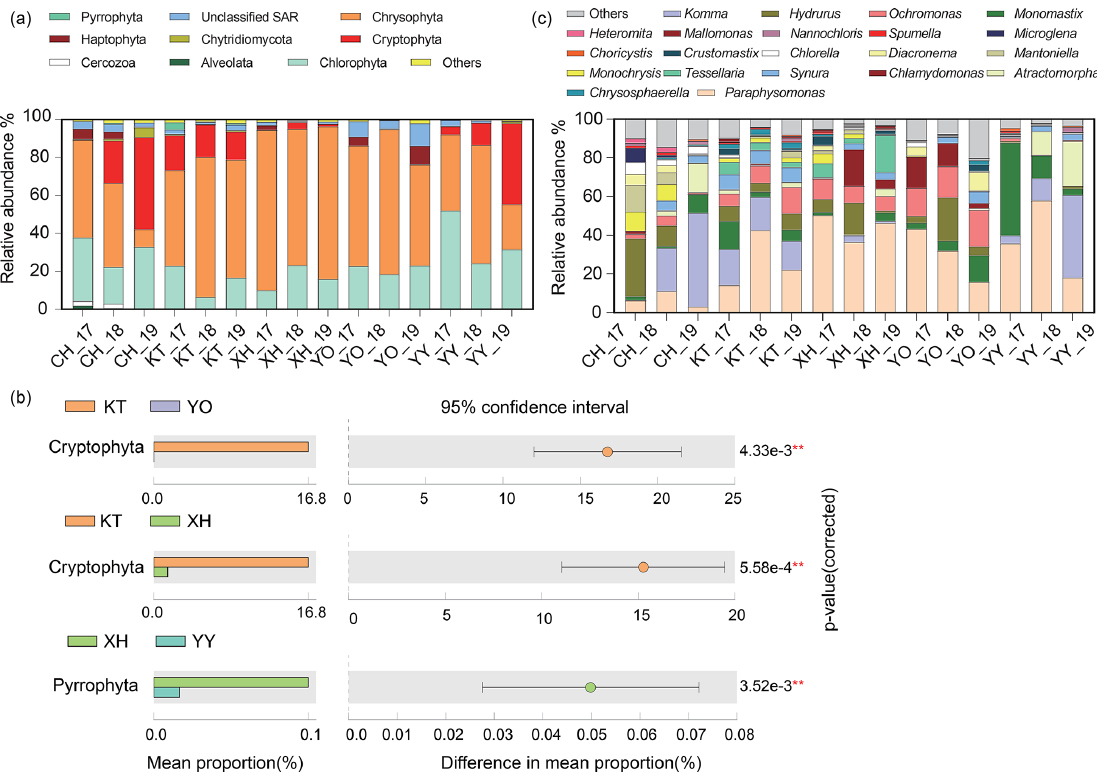
Figure 2. Comparison of microbial eukaryotic community composition. (a) Temporal and spatial dynamics of relative abundance on Phy- lum level in five lakes from 2017 to 2019. The 17, 18, and 19 represent the expedition seasons 2017/2018, 2018/2019, and 2019/2020, respectively. (b) Differential analysis of microbial eukaryotes in different lakes. The lakes that showed no significant differences are not shown ( P > 0 . 05). (c) Temporal and spatial dynamics of relative abundance on the genus level in the five lakes studied. (Note: ∗∗ P < 0 . 01, ∗ P < 0 . 05.) (Chlorophyta: Atractomorpha , Chlamydomonas , Mantoniella , Chlorella , Choricystis , Crustomastix , Microglena , Monomastix , Nannochloris ; Chrysophyta: Chrysosphaerell , Hydrurus , Mallomonas , Monochrysis , Ochromonas , Paraphysomonas , Spumella , Synura , Tes- sellaria ; Cryptophyta: Komma ; Haptophyta: Diacronema ; Cercozoa: Heteromita . Any lake where the relative abundance was less than 1% is defined as